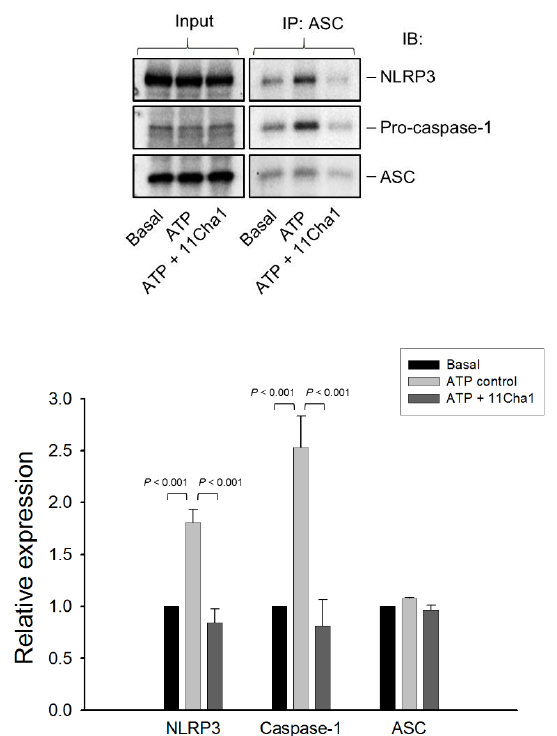
Figure 4. Effect of 11Cha1 on ATP-induced ASC dimerization and oligomerization. THP-1 cells were seeded and differentiated by 50 nM PMA for 48 h and then primed with 1 μg/mL LPS for 4 h. The cells were pre-treated with or without the indicated agent for 30 min (200 µM glyburide as the positive control) and then treated with 5 mM ATP for another 2 h. After treatment, the cells were harvested for the detection of the protein expressions of ASC dimerization and oligomerization. Data are expressed as mean ± SEM of at least three independent determinations. One-way ANOVA by Newman Keuls post hoc test was used. * P < 0.05 and ** P < 0.01 compared with ATP-treated control. The analyses of P (ANOVA) indicated P < 0.01 in all tests.